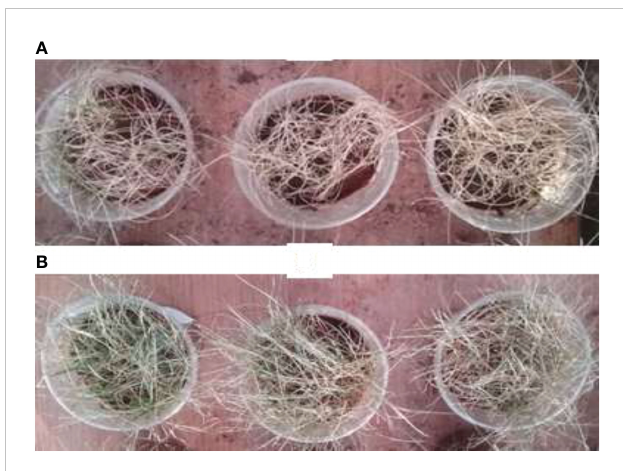
FIGURE 4 Visual appearance of the health status of ryegrass in disinfected soil. (A) : dead plants due to fusarium wilt disease induced by ( F ) nivale and (B) : negative